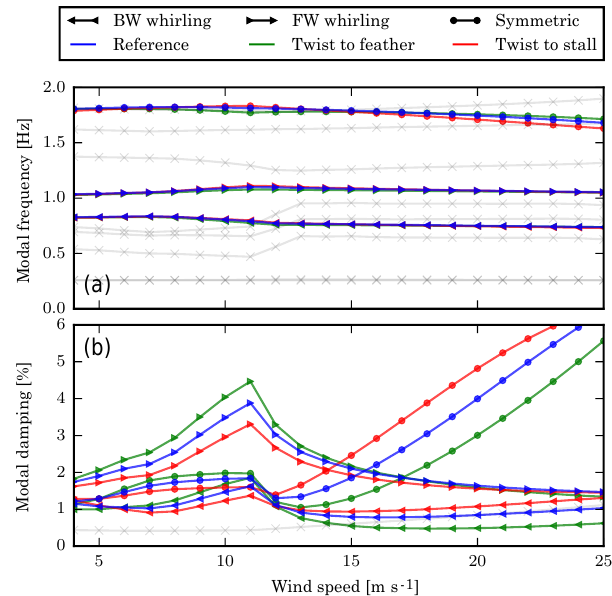
Figure 17. Aeroelastic frequency (a) and damping ratio (b) over the operational wind speed range of the first edgewise turbine modes for reference and edge–twist coupled blades with coupling coefficients γ x = ± 0 . 1. The grey lines indicate the remaining turbine modes (tower side–side, fore–aft, first flap backward whirling, symmetric, forward whirling, second flap backward whirling, symmetric, for- ward whirling from low to high frequency) of the reference